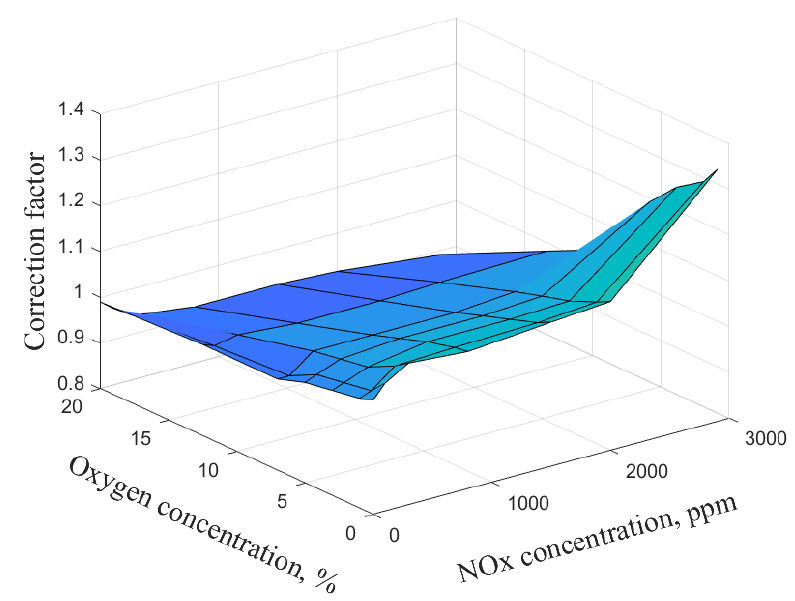
Figure 16. The oxygen concentration dependence of the NOx sensor.